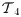
The transformation T4 in the proof of Proposition 25.